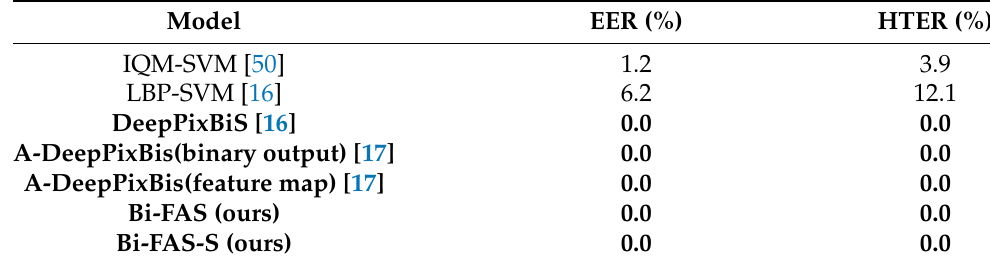
Table 4. Performance comparison of our proposed approach with other popular methodologies on the Replay-Mobile grandtest protocol [6].